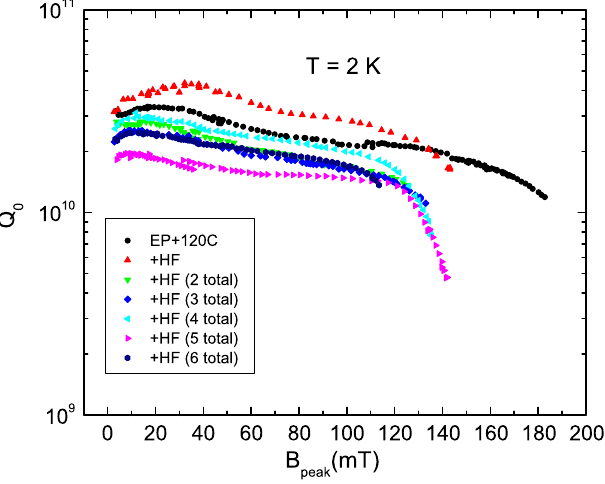
FIG. 4. Cavity rf test results after multiple HF rinse cycles for the buffered chemical polished cavity